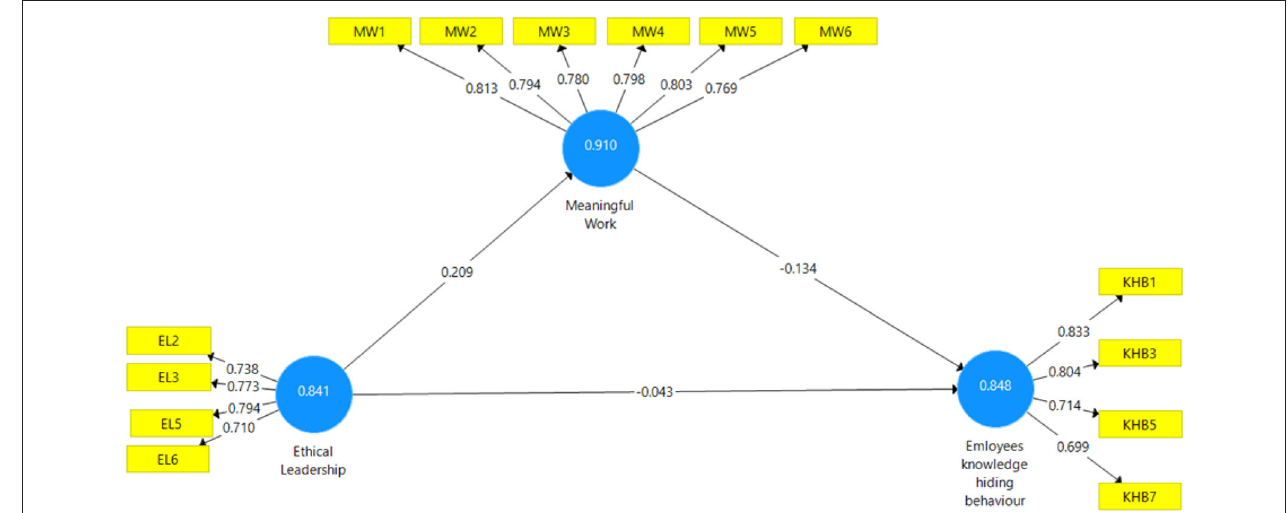
FIGURE 2 | Construct reliability and validity.